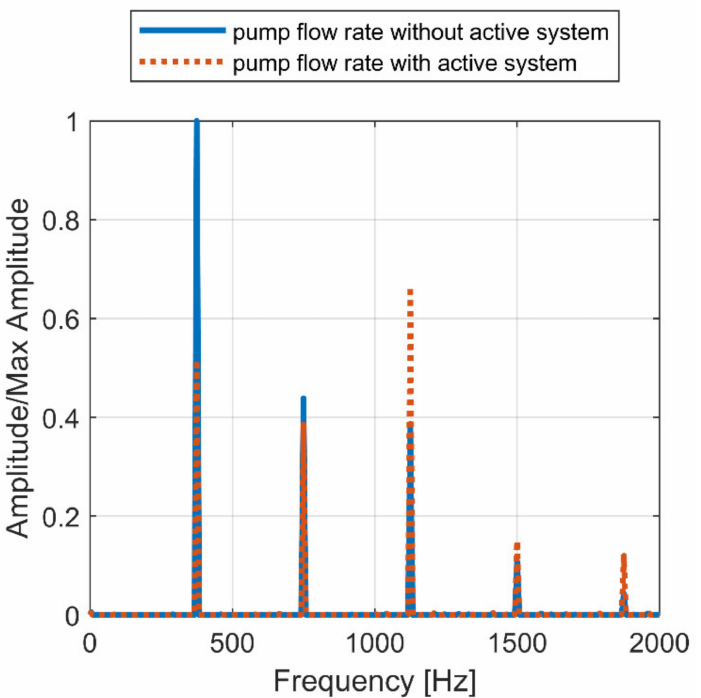
Figure 18. Limited current simulation, section 1: flow ripple FFT at 250 bar, 2500 rpm, 100% swash plate